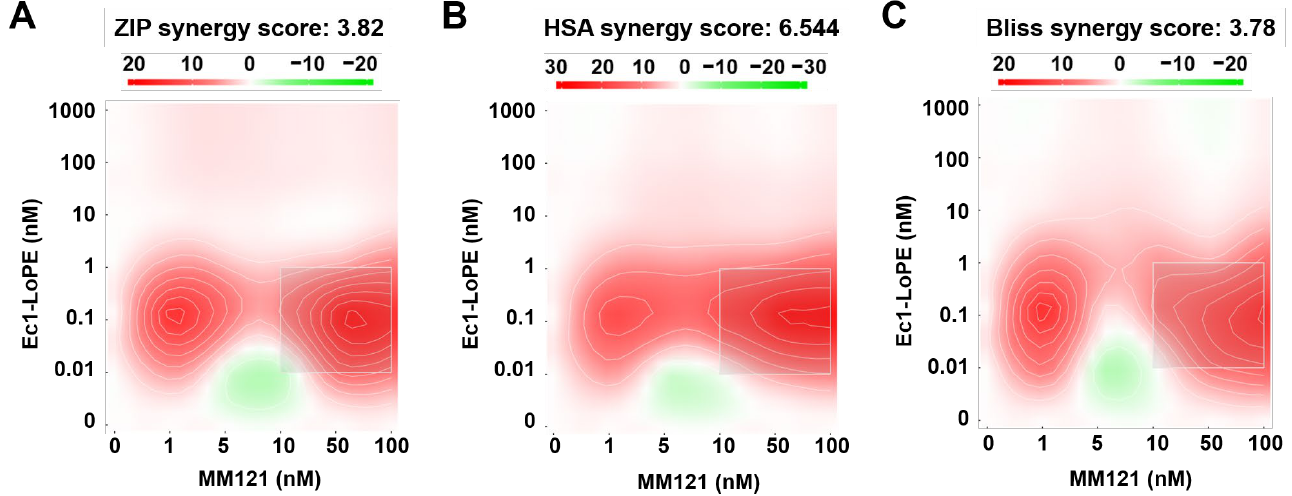
Figure 4. Heat map of synergistic effects. The viability of BxPC3 cells after incubation with Ec1–LoPE (0–1000 nM) and MM-121 (0–100 nM). Graphs display Ec1–LoPE concentration (nM) on the y -axis and MM-121 concentration (nM) on the x -axis. Values equal to zero (white area) are counted as an additive effect. Values above zero (white to red area) are counted as a synergistic effect, and values below zero (white to green area) are counted as an antagonistic effect.